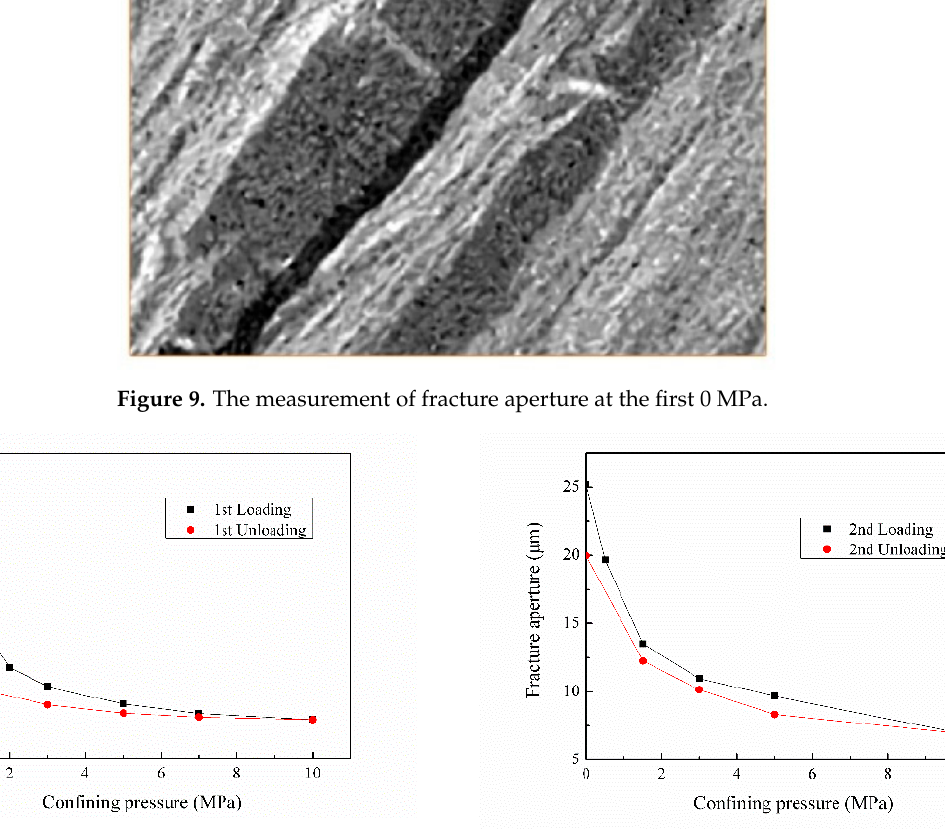
Figure 10. The measurement results of fracture aperture: ( a ) the first cycle, ( b ) the second cycle.